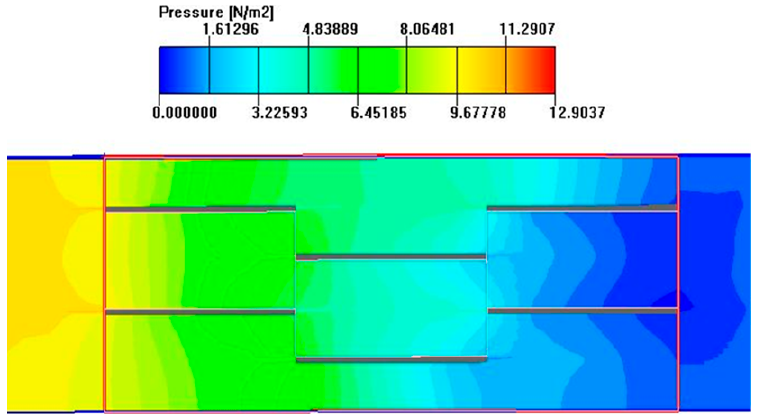
Figure 9. Pressure contour of fi n.